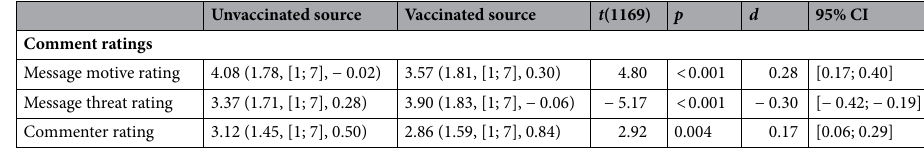
Table 1. Mean comment ratings and by comment source (collapsed across participant vaccination status). Standard deviations, range, and skew are in parentheses. Reporting adjusted estimates for Cohen’s